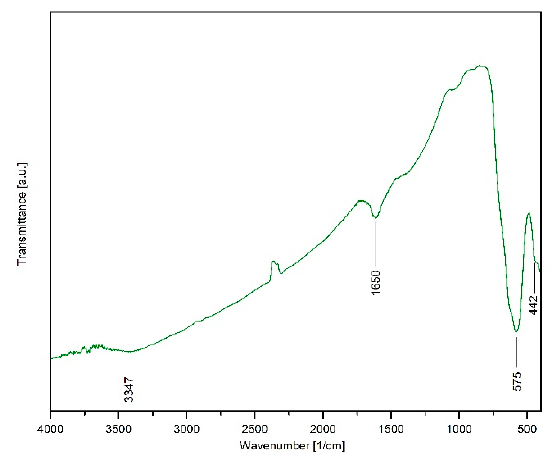
Figure 4. FTIR spectrum of the Fe 3 O 4 @C matrix.